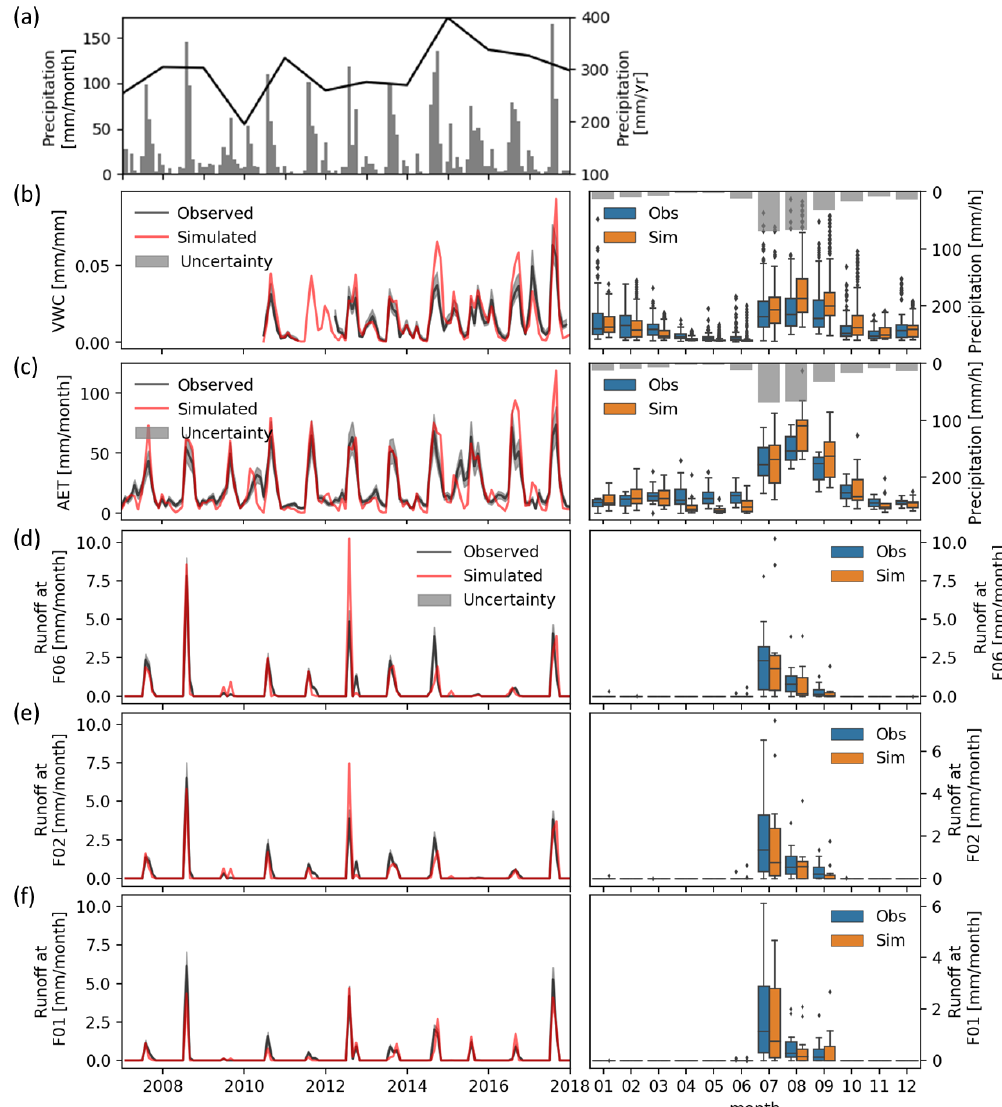
Figure 10. Comparison between observed and simulated values of monthly temporal variation (a–f) and monthly distribution (b–f) of (a) monthly precipitation (left axes) and yearly precipitation (right axes), (b) soil moisture at the COSMOS Kendall location, (c) actual evapotranspiration at Kendall, (d) streamflow at flume F06, (e) streamflow at flume F02, and (f) streamflow at flume F01. See Fig. 4 for station